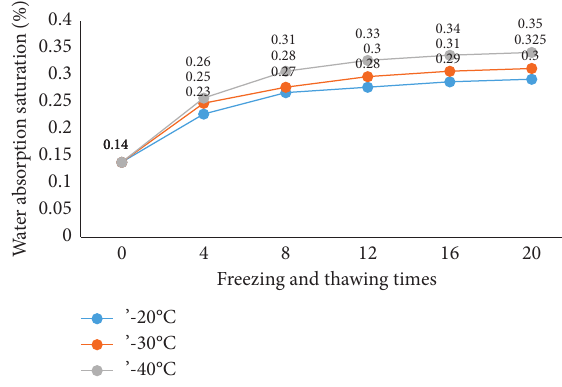
Figure 1: Rock sample water saturation rate.